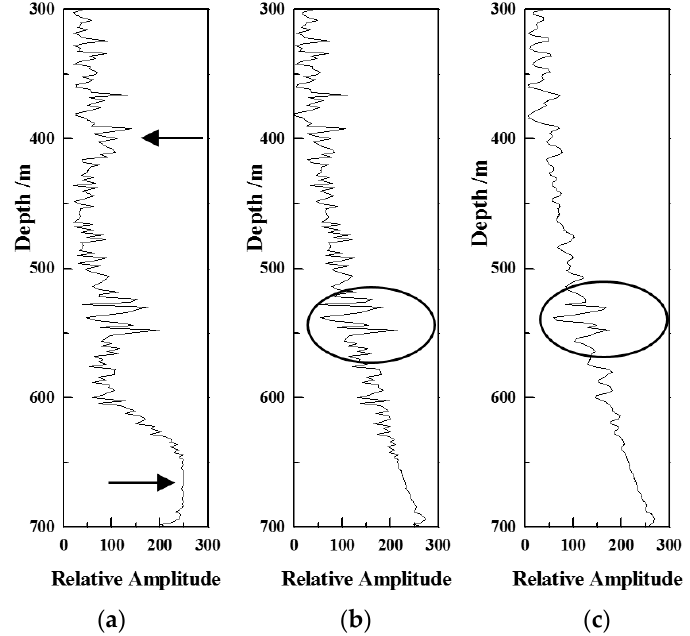
Figure 12. Curve comparisons after the magnetic amplitude data processing. ( a ) Raw measured magnetic amplitude curve. The arrows from top to bottom refer to the power frequency noise of 250 Hz and 150 Hz; ( b ) The measured data is processed after the EMD method; ( c ) The measured data is reconstructed after the EMD method and wavelet denoising. The abnormal signals are circled by ellipses in each figure.